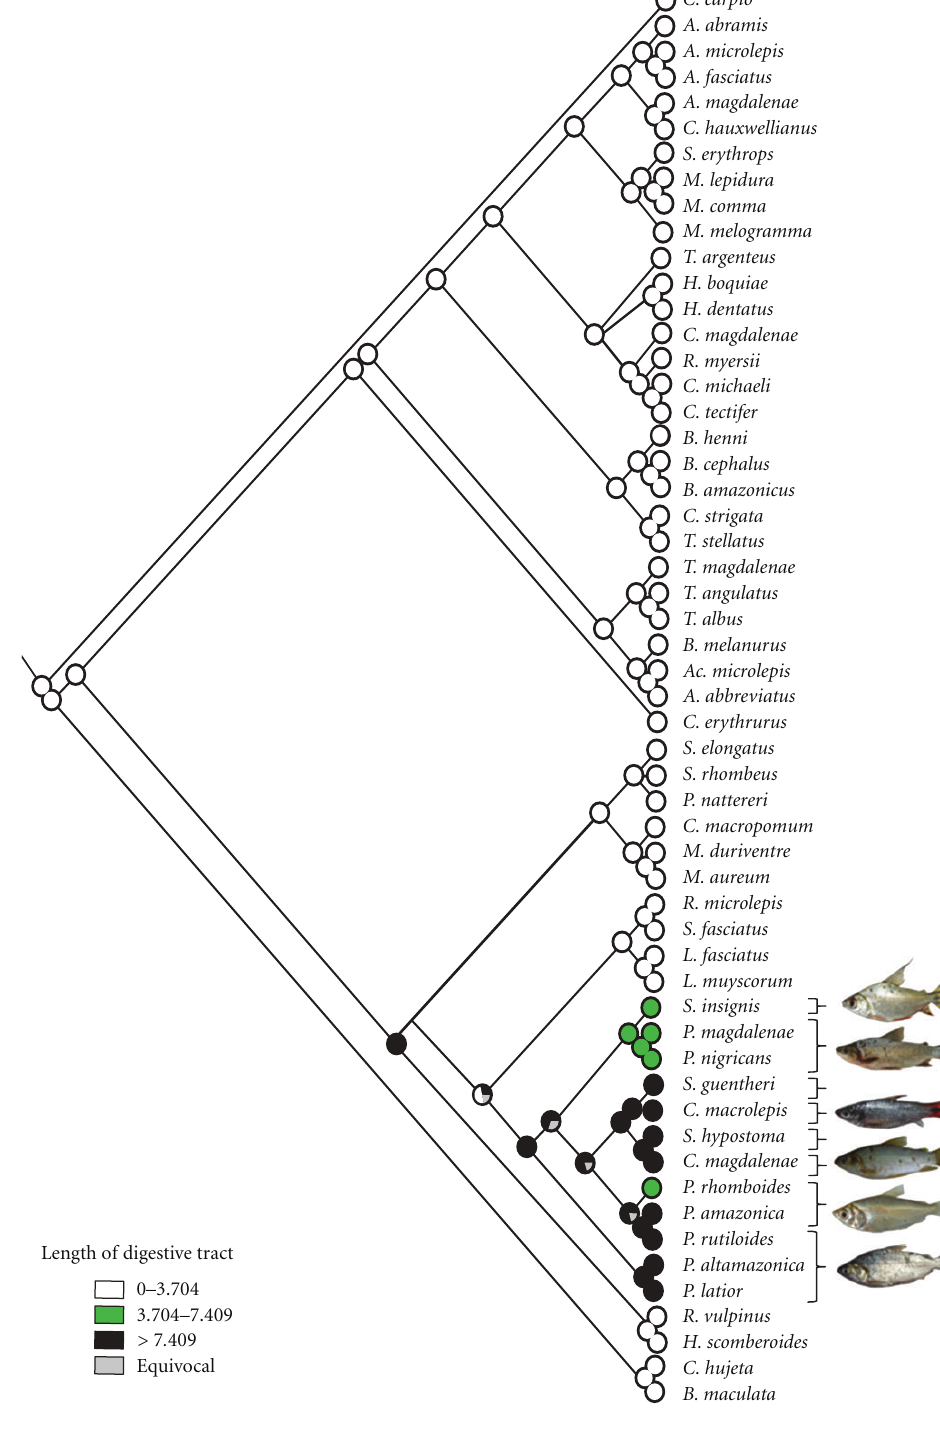
Figure 9: Reconstruction of digestive tract shown on consensus tree in 800 trees with Bayesian inference. Pie charts at major nodes show posterior probabilities from stochastic analysis of ancestral state reconstructions, assuming that character-state evolution is